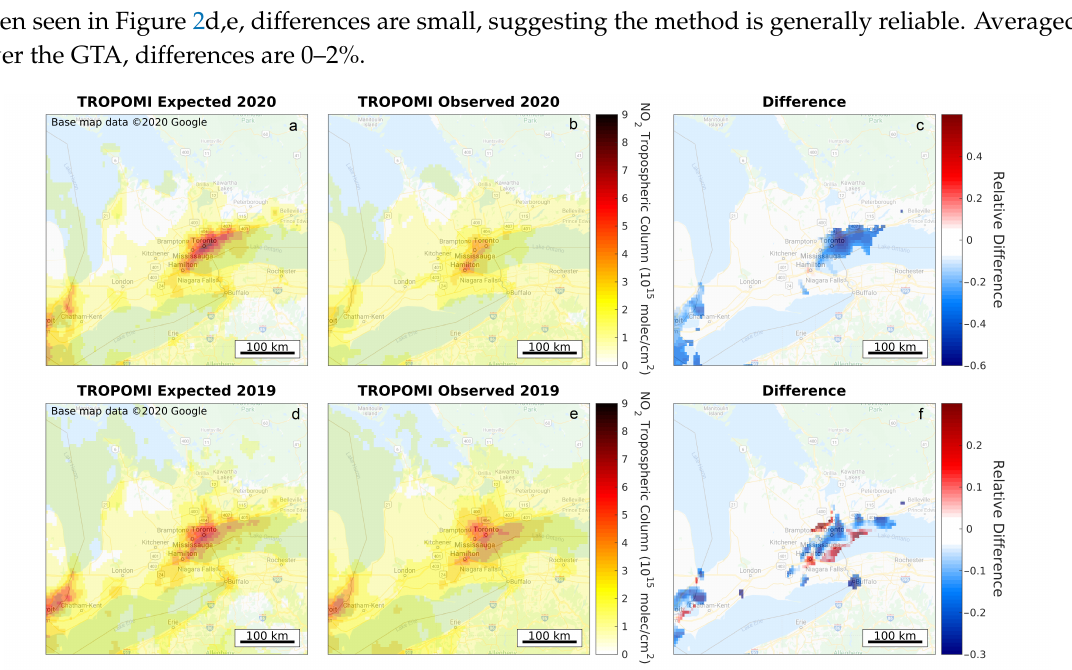
Figure 2. The figures show the expected and observed TROPOMI averaged NO2 VCDs over southern Ontario for 2020 and 2019. Expected and observed TROPOMI average VCD fields for the lockdown period (16 March–8 May 2020) are shown in panels ( a , b ), respectively. The same is shown in panels ( d , e ), but for 16 March–8 May 2019. Relative differences ((observed-expected)/expected; for areas that exceed 3 × 10 15 molec/cm 2 ) between the TROPOMI observations and the expected columns are shown in panel ( c , f ) for 2020 and 2019, respectively. Note that panel ( b ) is the same as Figure